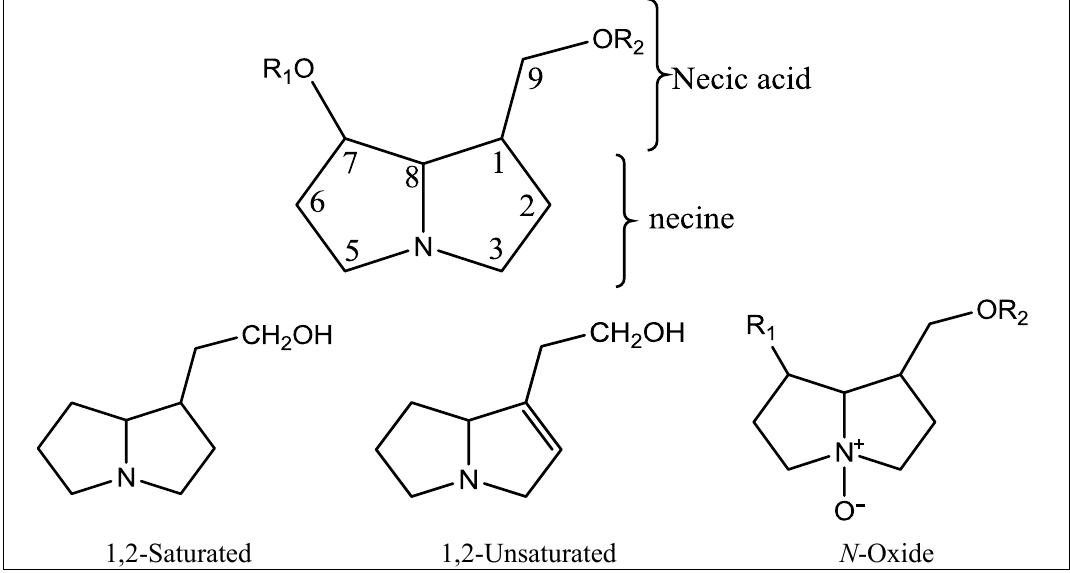
Figure 1. Basic structures of pyrrolizidine alkaloids in Boraginaceae.